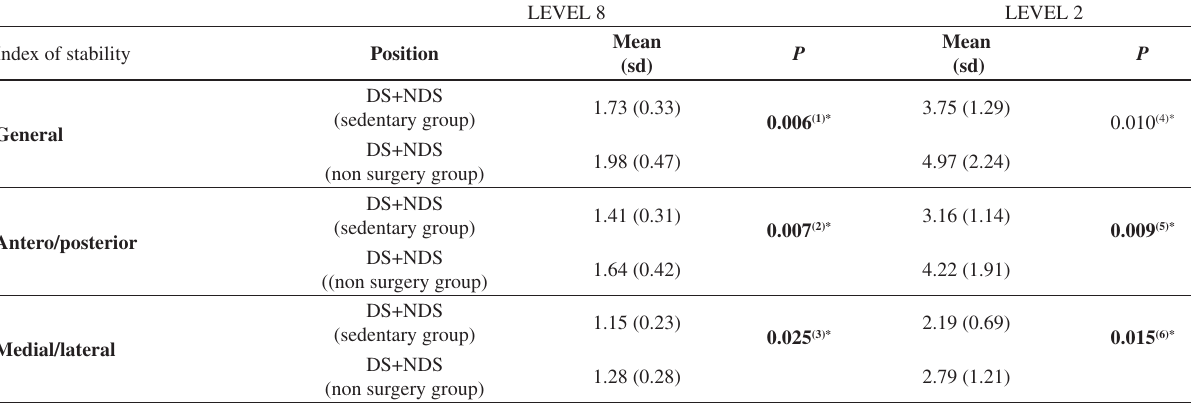
Table 4 - Intergroup comparison of the center of gravity dislocation and postural balance in the Sedentary Group (DS and NDS) versus the Non-surgery Group (DS and NDS) at stability levels 8 and